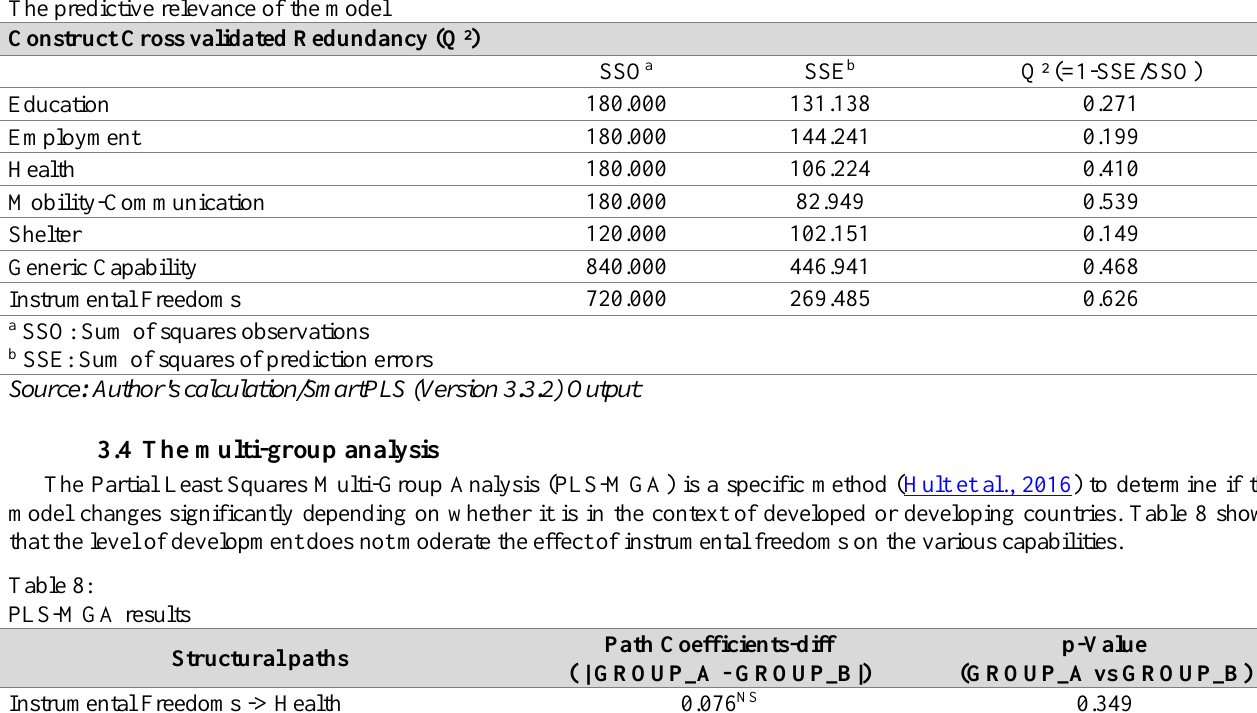
The predictive relevance of the model